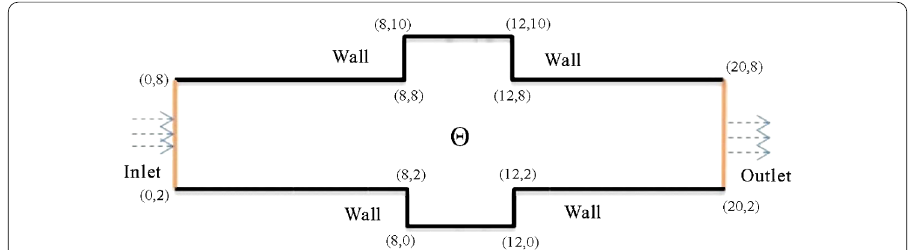
Figure 1 The calculated region along with boundary conditions of